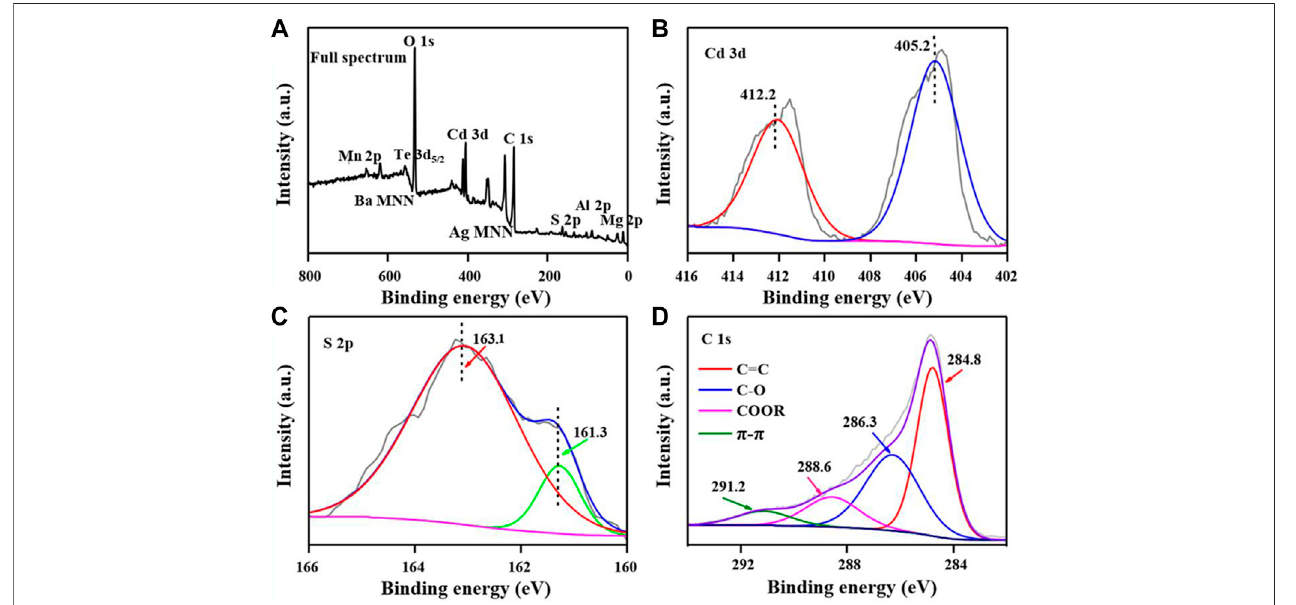
FIGURE 3 | (A) XRD spectra of CP, Cd-CP, and CdS@CP; (B) HRTEM images of CDS@CP; (C) DRS spectra of CdS and CdS@CP; (D) the band-gap energy of CdS and CdS@CP.